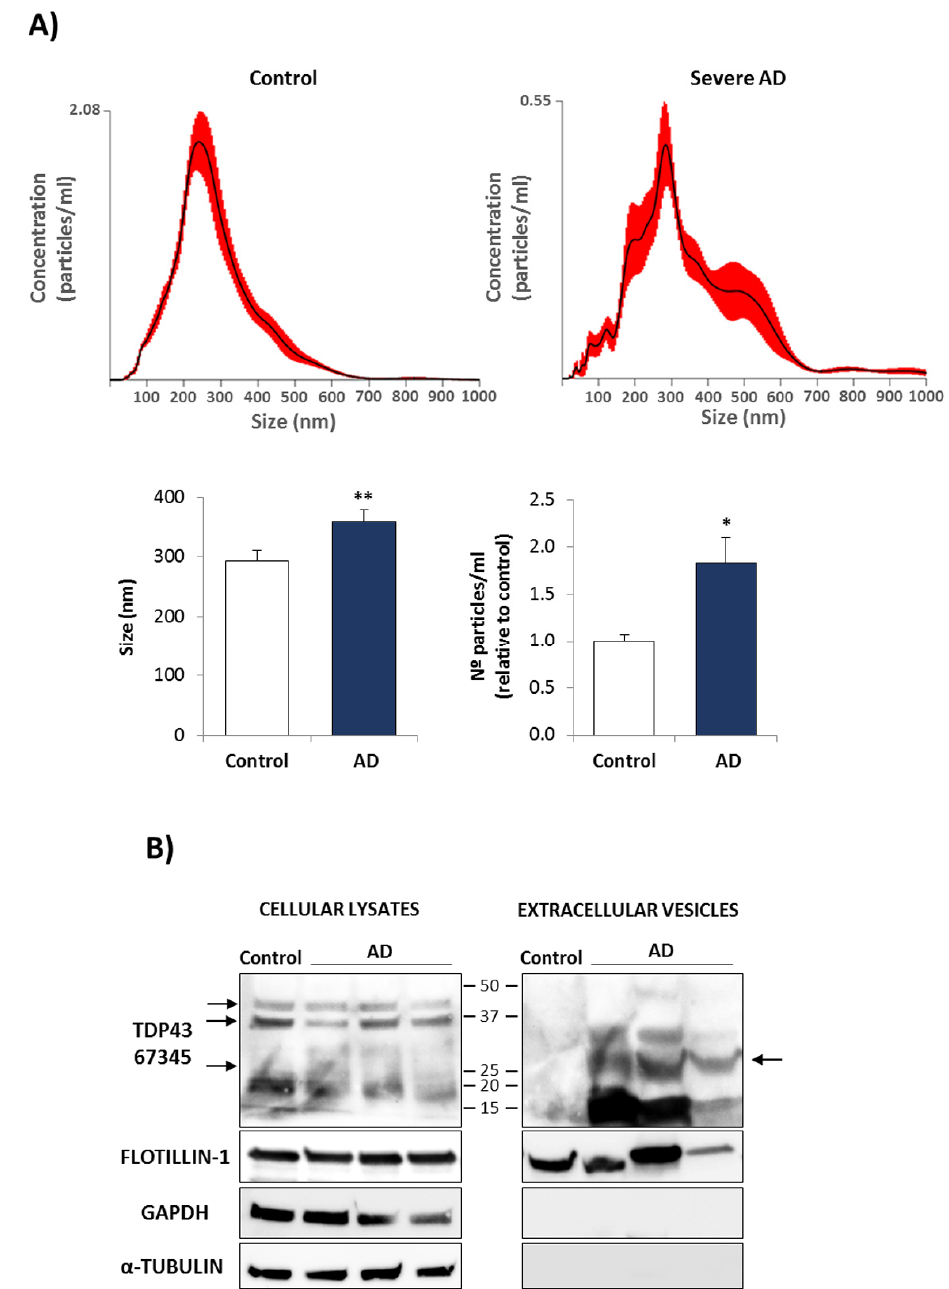
Figure 7. Extracellular Vesicles isolated from AD lymphoblasts showed an increase in size and concentration and were enriched in fragmented TDP-43. ( A ) Quantification of size and concentration of EVs released from control or severe AD lymphoblasts by NTA. Bars are the mean ± SD of three independent experiments. Statistical analysis was performed using the Student t test. (* p < 0.05, ** p < 0.01) ( B ) Western blot analysis of C-t TDP-43 in cellular lysates or extracellular vesicles of the indicated samples. α -tubulin and GAPDH were used as negative controls for EVs and Flotillin-1 as positive control. The arrow points to the 25 KD TDP43 fragment.